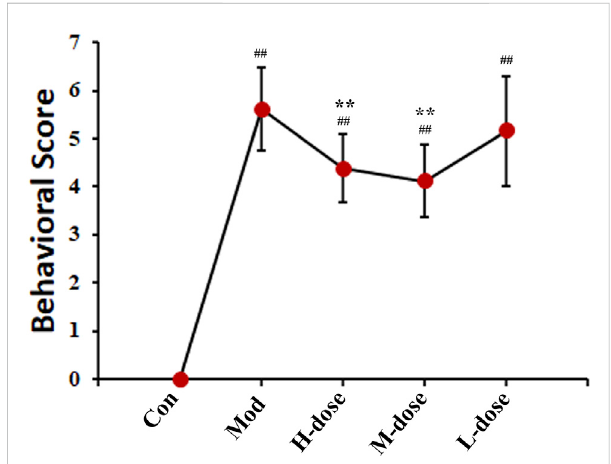
FIGURE 1 SXCF decreased the frequency of asthmatic behaviours ( n = 6, ## vs . Con, p < 0.05, * vs . Mod, p < 0.05, data were expressed as mean ± standard deviation [one-way ANOVA followed by LSD